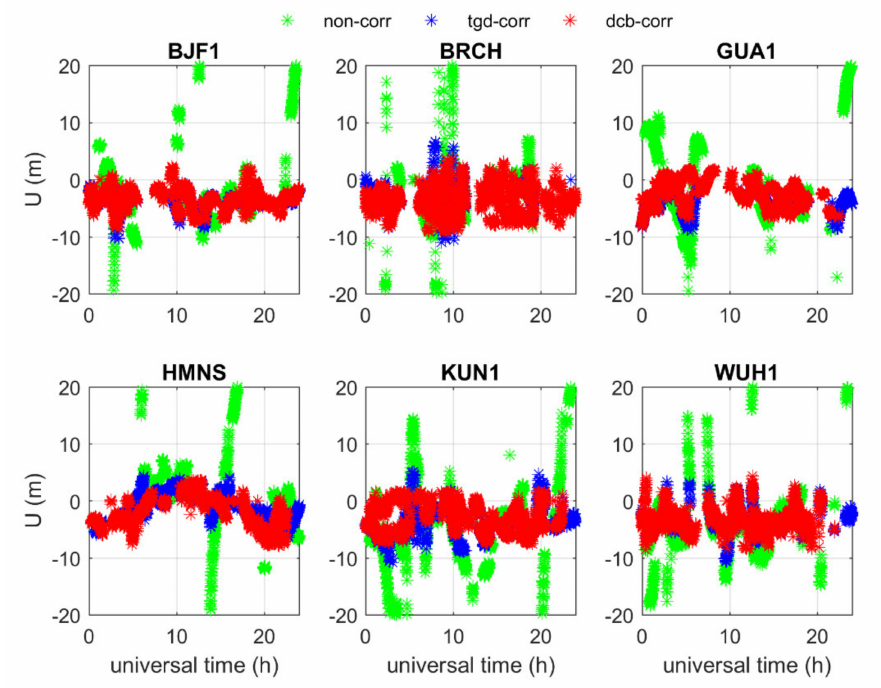
Figure 10. Vertical positioning error scatters with and without TGD or DCB correction of B2a SPP at six